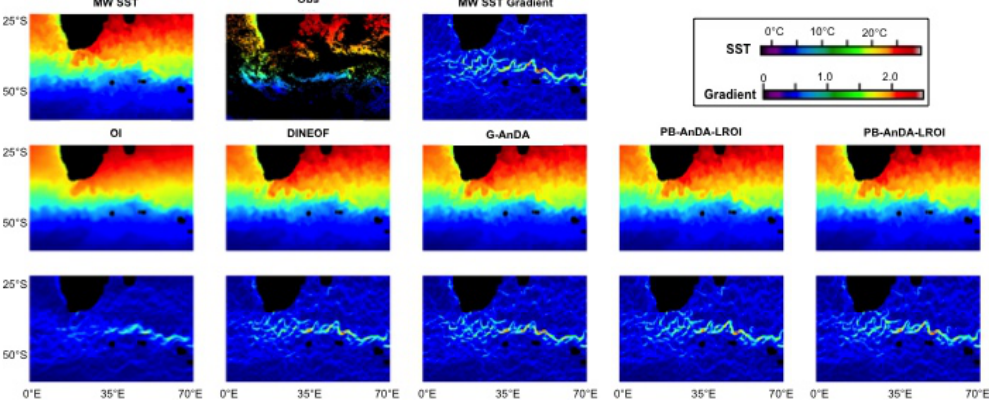
Figure 1. Reconstructed SST fields using OI, DINEOF, G-AnDA, PB-AnDA-LROI + dX + Z , PB-AnDA-LRM + dX + Z on day 150th for MW SST case-study: the first row depicts the reference SST field, the cloudy observation and the gradient magnitude; the second and third rows depict respectively the SST fields and their gradient magnitude for OI, DINEOF, G-AnDA, PB-AnDA-LROI + dX + Z , PB-AnDA-LRM + dX + Z . It may be noticed that PB-AnDA-LROI + dX + Z and PB-AnDA-LRM + dX + Z better reconstructs fine-scale structures for instance along the Aghulas return current as well as south of Madagascar